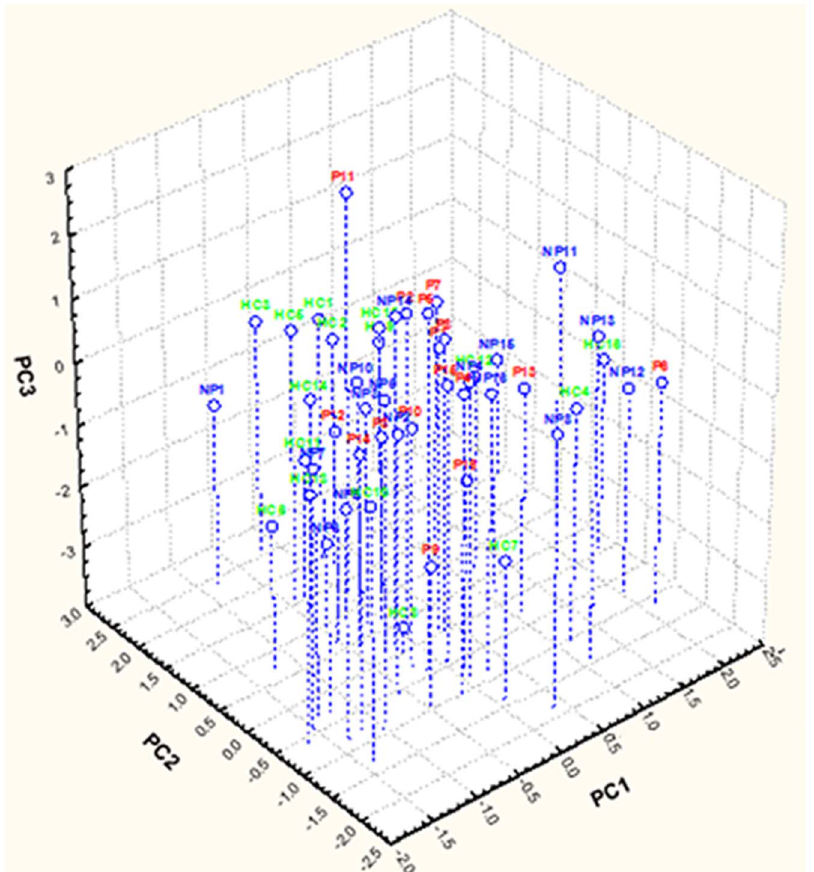
Figure 4. Principal component analysis (PCA) of total bacterial genera found in feces of subjects. Score plot of the three principal components (PC) after principal component analysis (PCA) of total bacterial genera (16S rDNA), which were found in the fecal samples of immunoglobulin A nephropathy (IgAN) non progressor (NP) and progressor (P) patients, and healthy controls (HC). 1–16, number of fecal samples for each group of subjects.